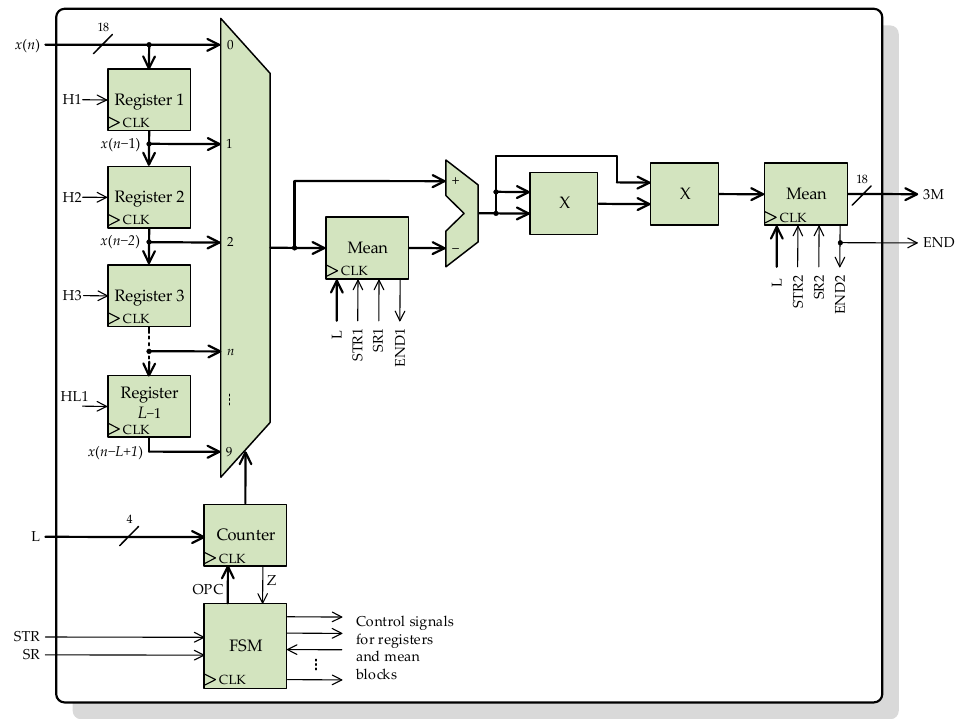
Figure 8. Architecture of the processing core for computing the moving third-order central moment. The mean structure, whose basic architecture is shown in Figure 9, is based on a digital structure known as accumulator. An accumulator is composed of an adder and two parallel registers. Both register inputs are connected to the adder output, whereas one register output is connected in feedback to one of the adder inputs. The function of this structure is to compute successive sums using only one adder. After the accumulator, a divider structure is used to divide the sum of all samples of the input signal x ( n ) between the number of samples L , obtaining the mean (18-bit MEAN signal). There is no division operator in the IEEE standard VHDL libraries, so it is necessary to design a digital structure for this purpose. The divider is based on a successive approximations register (SAR). This divider computes the division using a successive approximations approach. The SAR successively approximates the quotient value, comparing the quotient and divisor product, with the dividend until the product value is equal or very close to the dividend value.